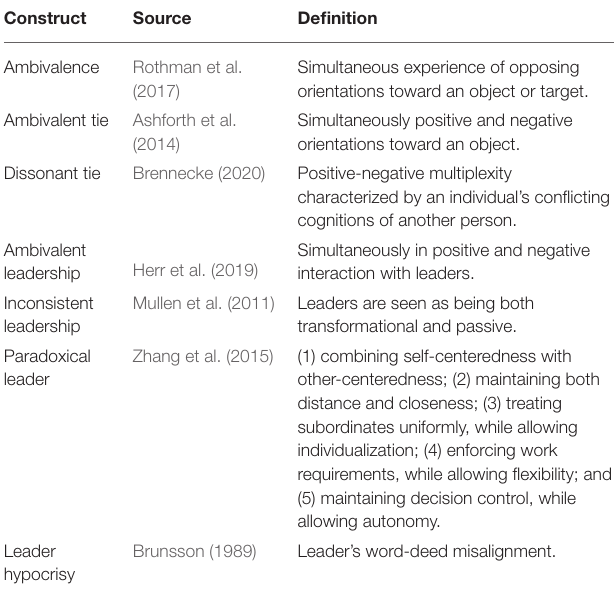
TABLE 1 | Key definitions about ambivalent relationship and leader–follower ambivalent